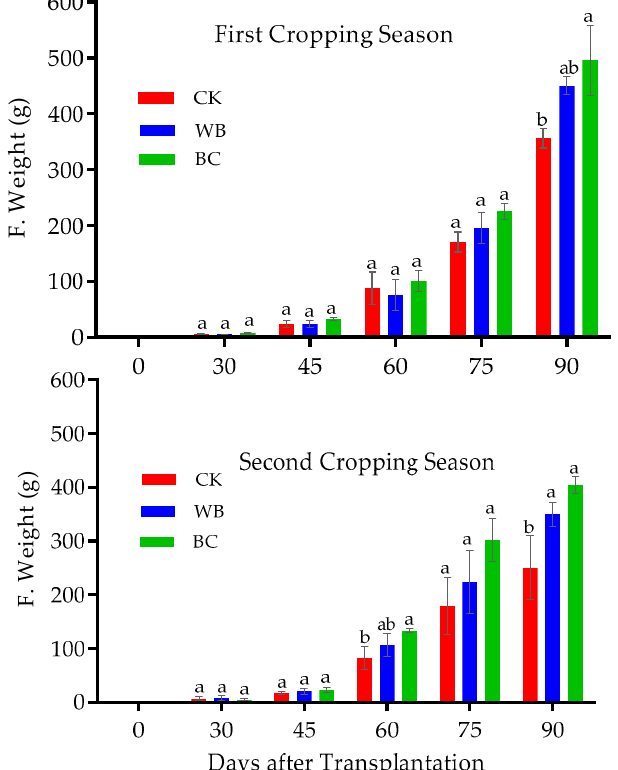
Figure 6. Presents the mean value with error bars (SEM) for the cumulative dry weight (DW) growth in grams (g) against days after transplanting in two cropping seasons while cropping Brassica Camprestis Var. Chinensis in lysimeter experiments for BC (biochar added and 15 N-urea), WB (without biochar added and 15 N-urea), and control (no added biochar as well urea). The small letters (a, b, c) present the level of significance among the treatments in a season according to the pair-wise Scheffe test.